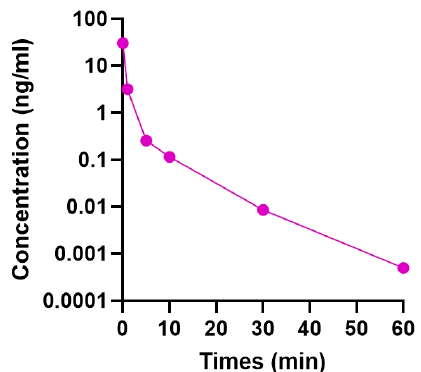
Figure 1. Concentration–time profile in the vitreous of mouse eye following the intravitreal injection of 1 µ M trichostatin A (TSA).